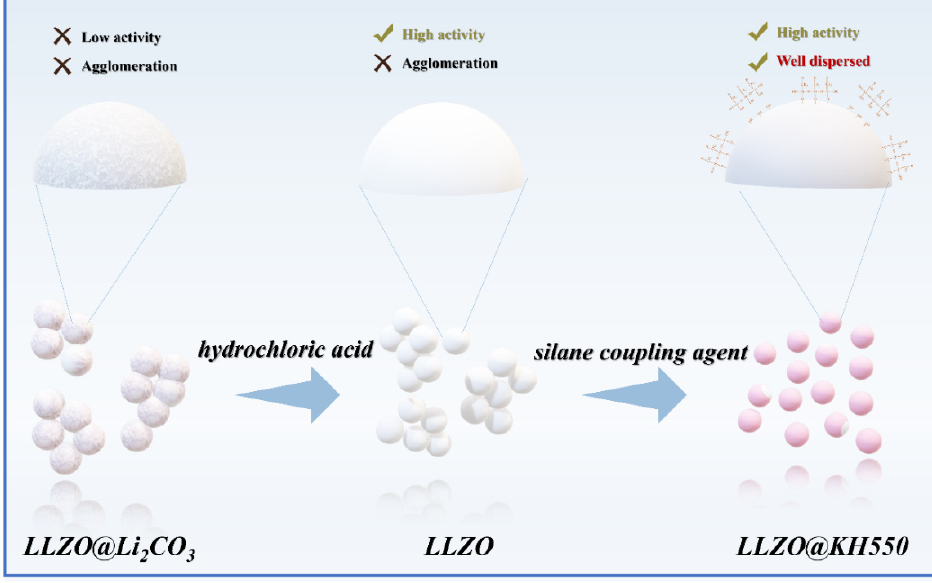
Figure 1. Schematic diagram of the process of coating LLZO with silane coupling agent KH550. at ~21 ◦ and 23 ◦ belong to LiOH and Li 2 CO 3 , respectively [30]. After the treatment with dilute hydrochloric acid, the peaks corresponding to LiOH and Li 2 CO 3 vanished, which indicates the surface Li 2 CO 3 and LiOH passivation layer of LLZO were completely